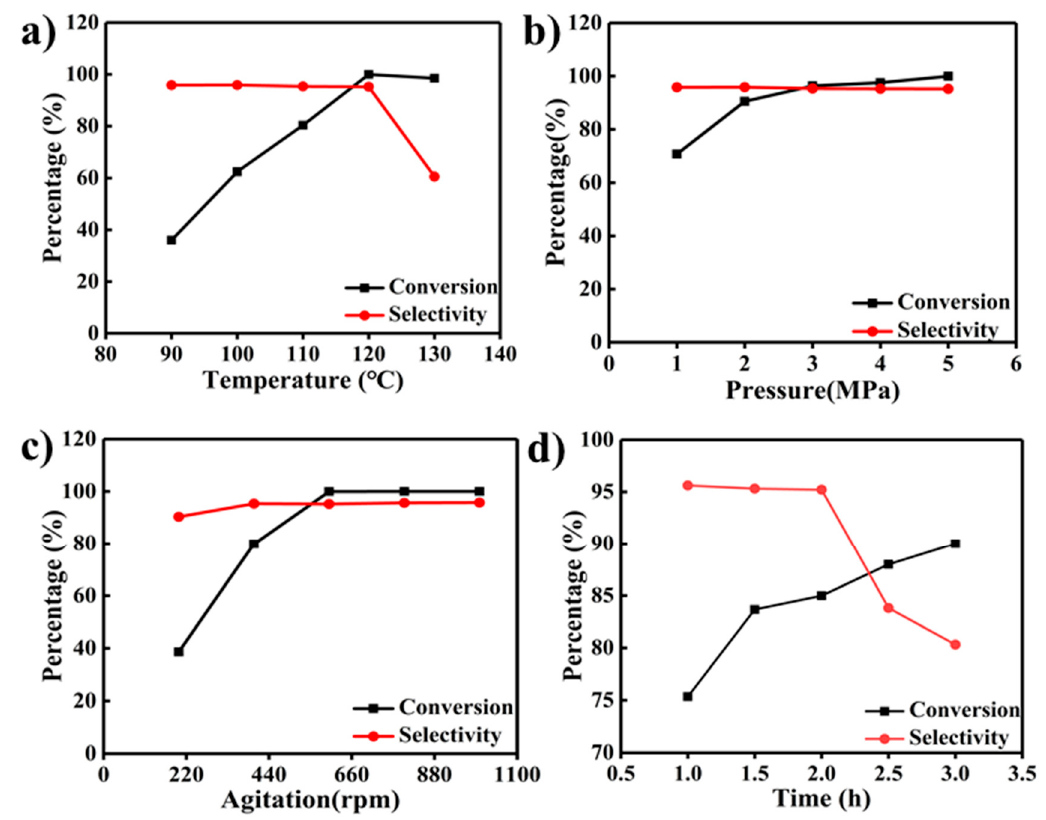
Figure 6. Catalytic activity and selectivity test with different conditions: ( a ) Temperature, ( b ) pressure, ( c ) agitation, and ( d ) time.